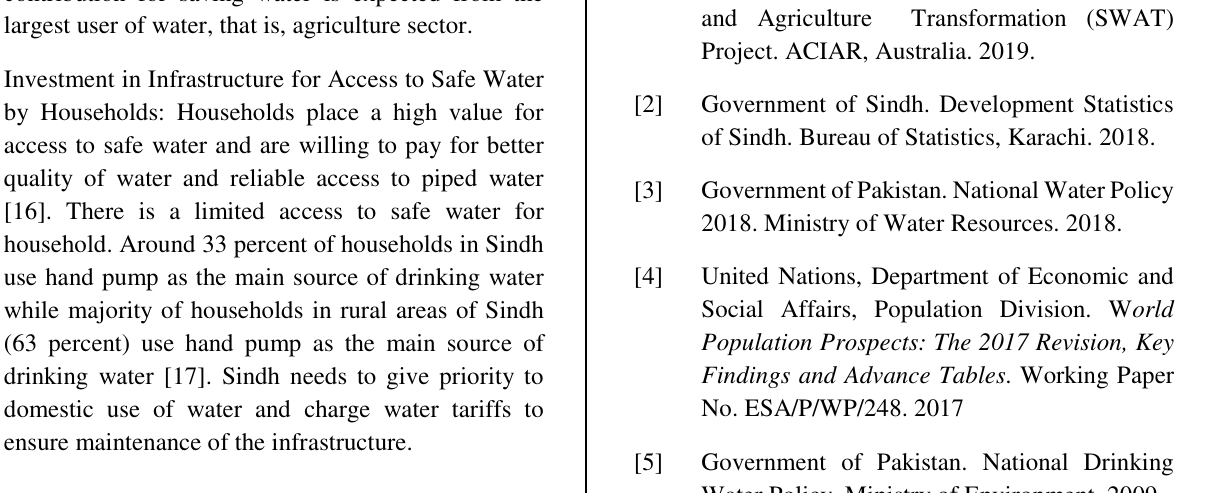
Table 7: Impact of Adaptation Investments in Pakistan No